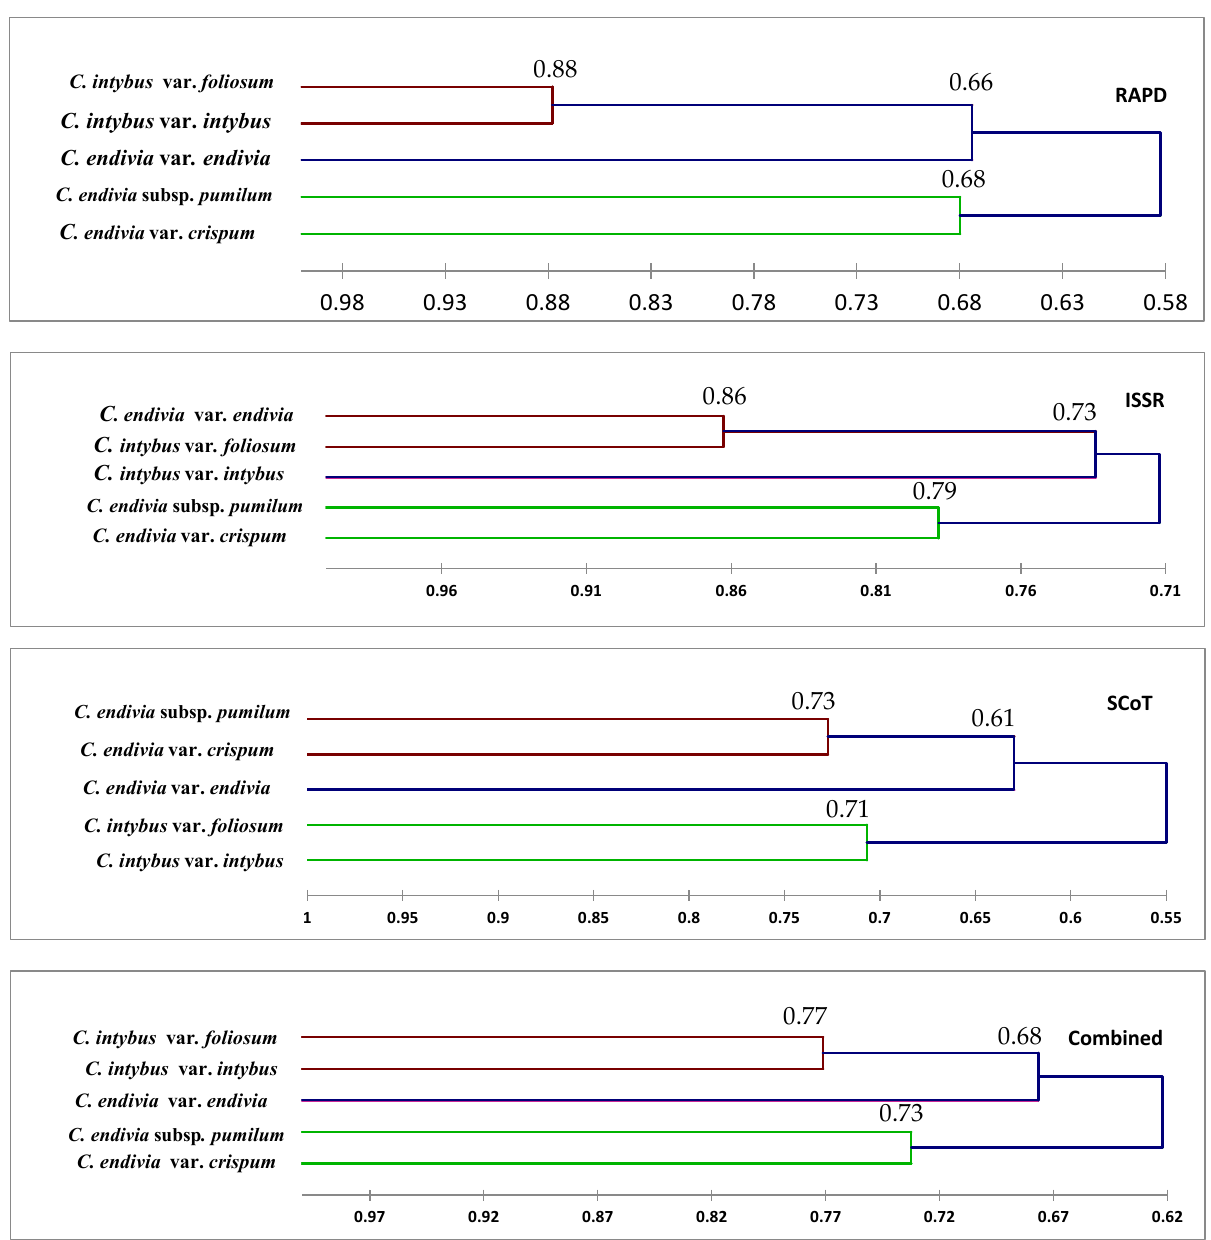
Figure 9. Dendrograms classified the five taxa of Cichorium by three molecular markers using UPGMA analysis. UPGMA